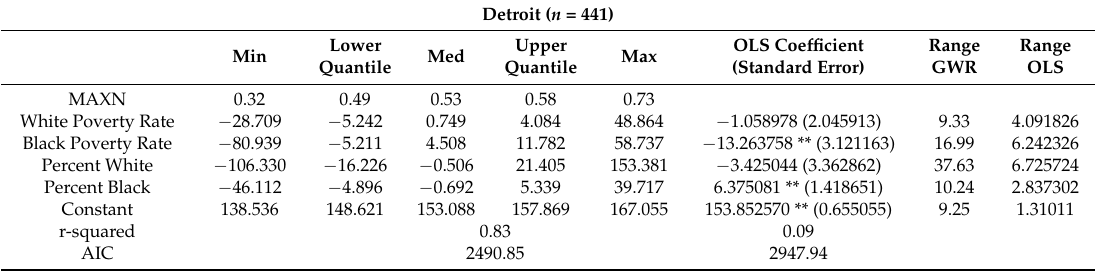
Table 7. Global and Local Parameter Estimates of the Geographically Weighted Regression Model for Detroit.